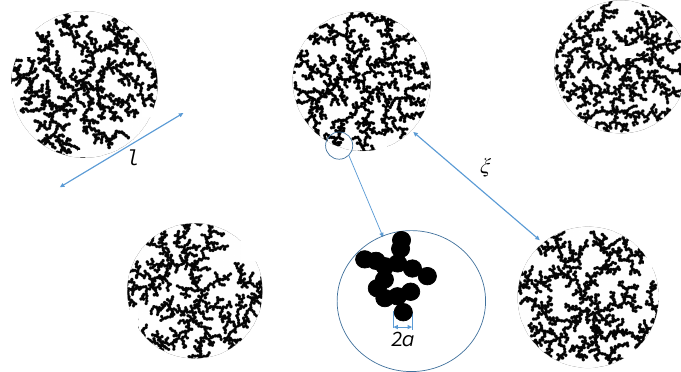
Figure 1. (Color online) Schematic representation of a two-dimensional model of interacting mass-fractal clusters of average overall size l , situated at distance (cid:39) ξ apart from each other, and consisting of spherical units of radius a , with a (cid:28) l